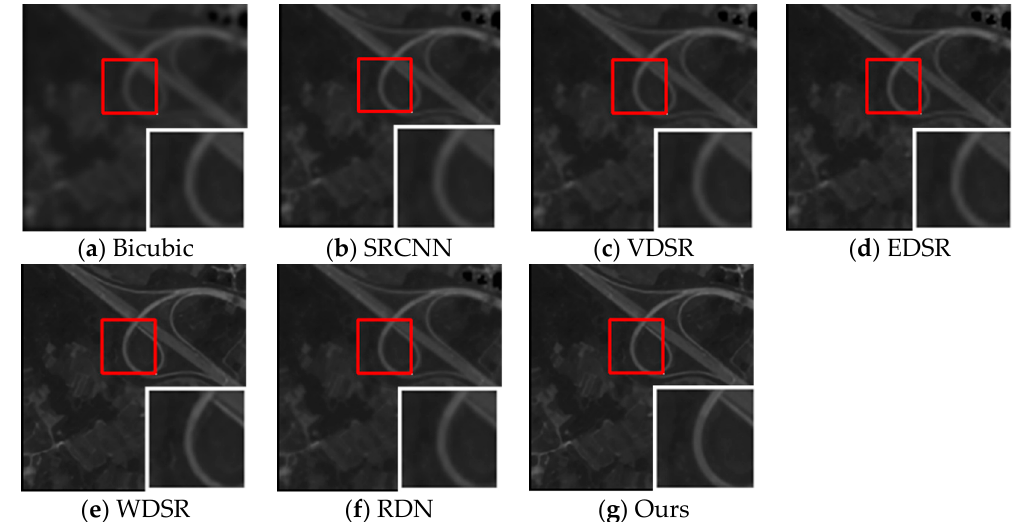
Figure 11. Qualitative comparisons of our model with other methods at the scale of ×3 on the GF-2 multispectral channels test set at the original scale displayed with red, green, and blue channels.